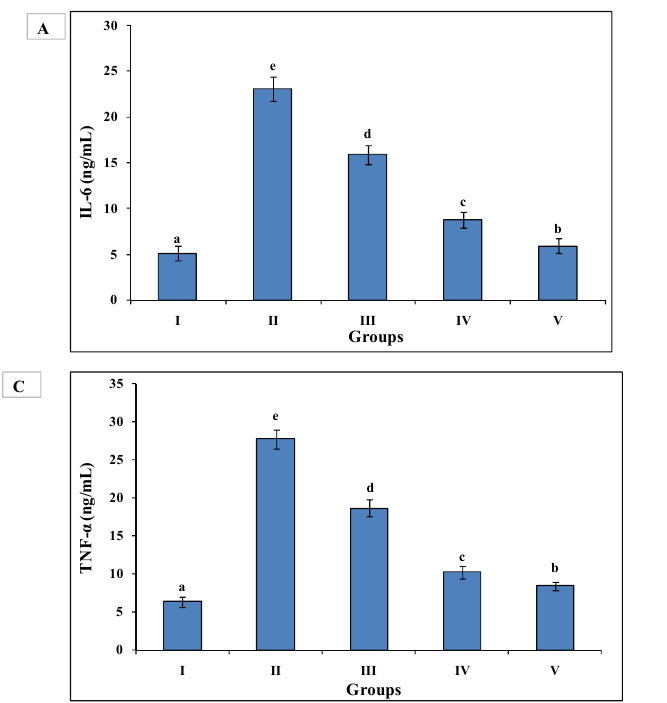
Figure 4. AAE treatment reduced levels of interleukins and TNF-α. AAE treatment reduced level of interleukins, ( A ) IL-6 (ng/mL), and ( B ) IL-1β (ng/mL) and, ( C ) TNF-α (pg/mL) in Groups III and IV. All values of Group IV close to silymarin-treated Group V. Group II had elevated levels of all parameters. Duncan’s multiple-range test (DMRT) was used for the analysis of a significant difference between the means ( p < 0.05) and to separately compare each parameter. Bars with the same letters are not significantly different. All the values are means of five replicates ± SD.